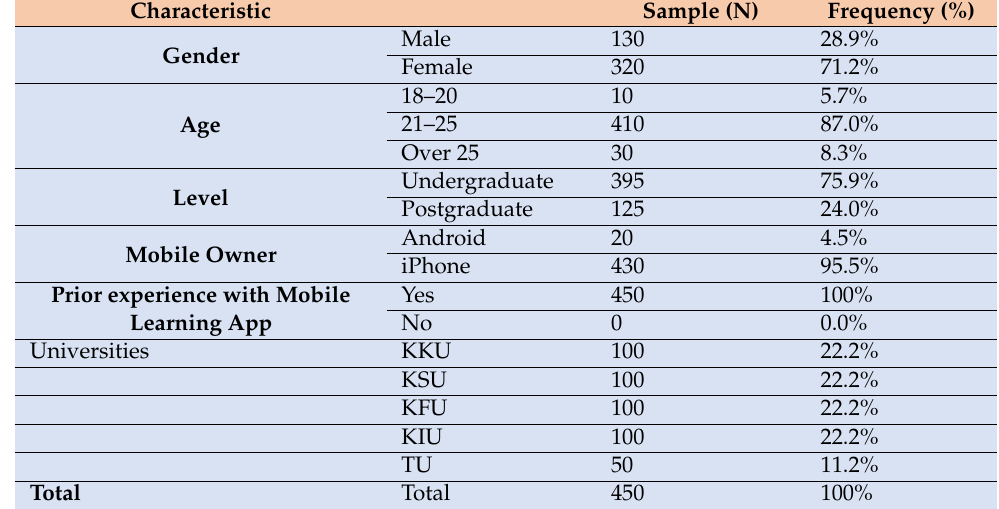
Table 3. Analysis of